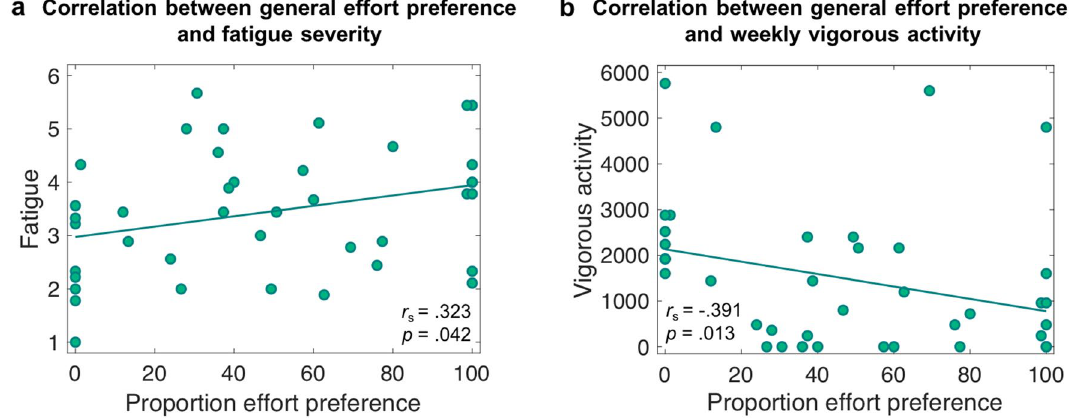
Figure 7. Correlation between general effort preference and effort sensitivity. ( a ) Correlation between the percentage of trials in which a participant chose to first see the effort information and self-reported fatigue (FSS score on a scale between 1 and 7). ( b ) Correlation between the percentage of trials in which a participant chose to first see the effort information and the intensity of vigorous activity undertaken, as assessed with the IPAQ. Vigorous activity is reported in MET-minutes per week. Figures show that a stronger preference for seeking effort information first is associated with higher levels of fatigue, and with reductions in vigorous physical activity in everyday